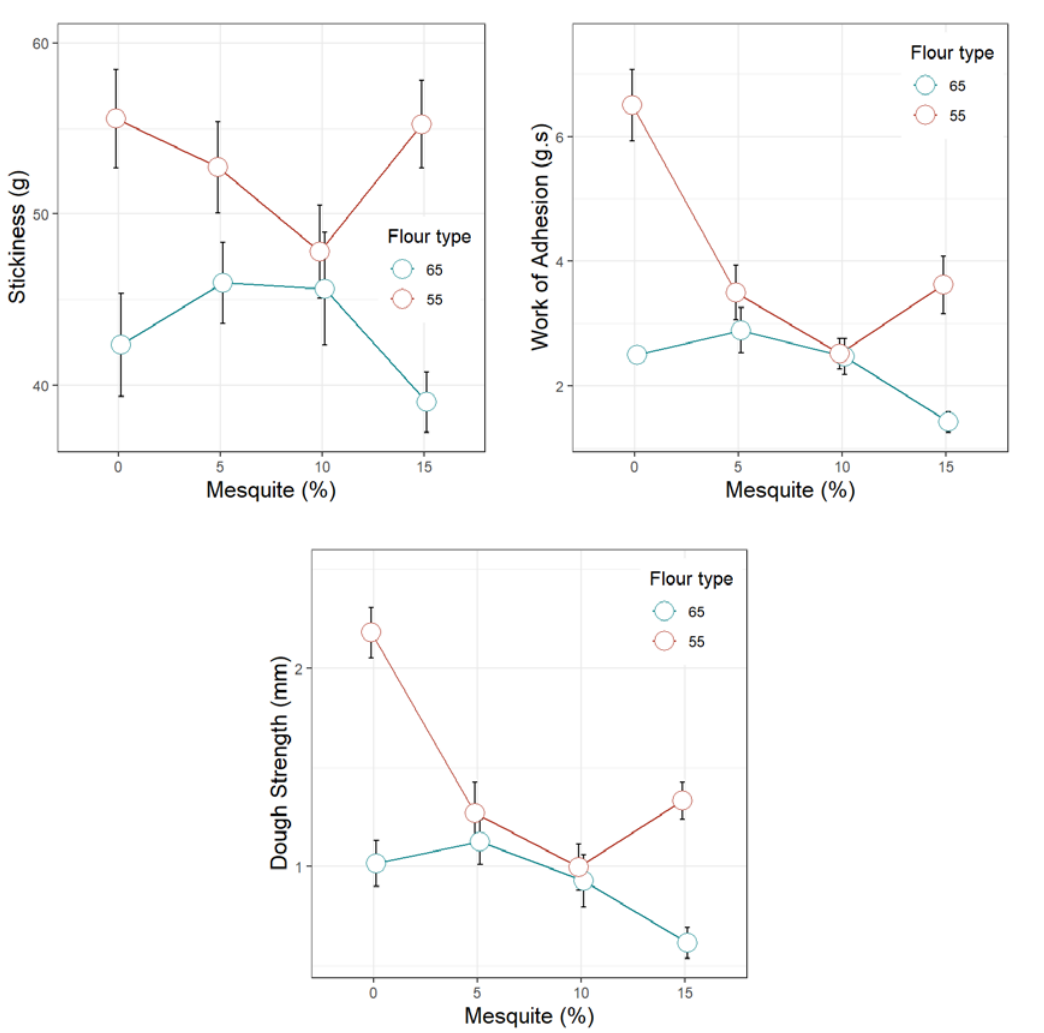
Figure 1. Stickiness properties of dough made of wheat flour type 65 or 55 partially replaced with mesquite pod flour.